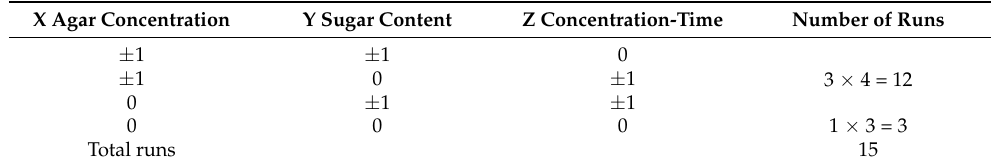
Figure 1. Experimental design of gelatinized adzuki-bean cake. Table 1. Experimental design for three variables—three levels response surface analysis of gelatinized adzuki-bean cake.